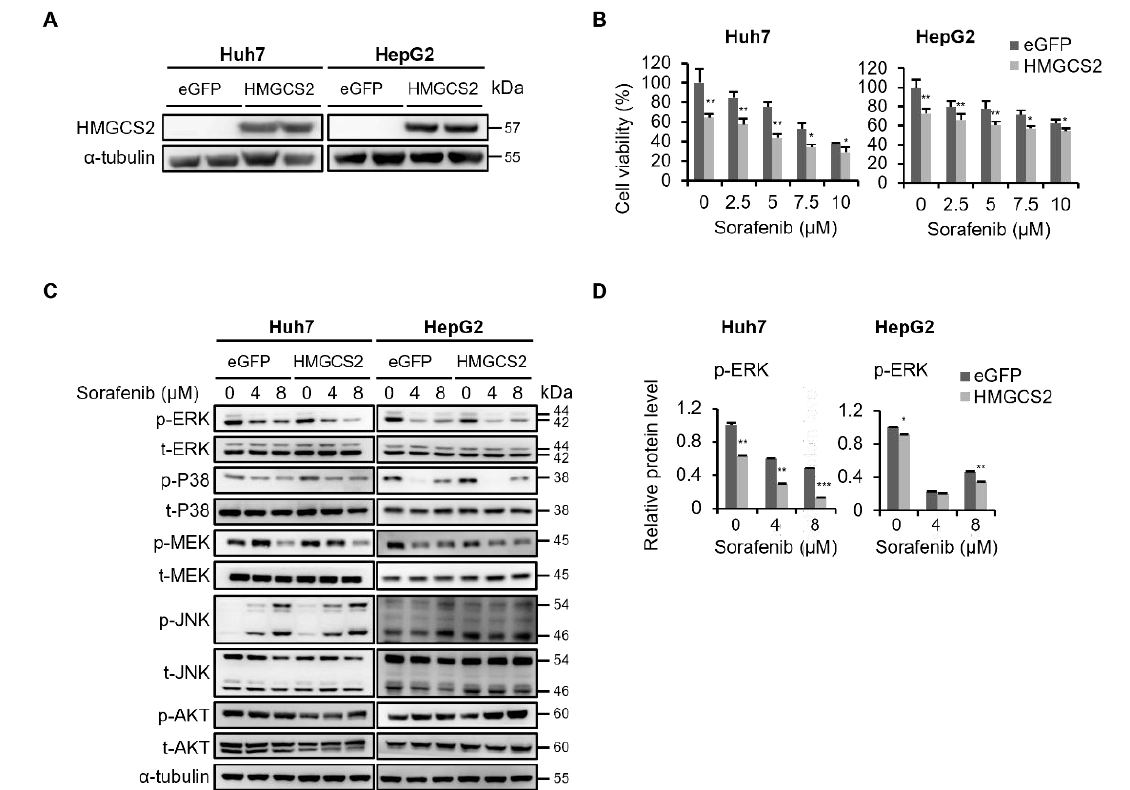
Figure 2. Overexpression of HMGCS2 in sorafenib-treated Huh7 and HepG2 cells exhibited an inhibitory effect on mitogen-activated protein kinase (MAPK)/extracellular signal-regulated kinase (ERK) activation. ( A ) Western blot analysis of HMGCS2 overexpression in Huh7 and HepG2 cells. ( B ) Enhanced green fluorescent protein (eGFP) control and HMGCS2-overexpressing Huh7 and HepG2 cells were treated with 0, 2.5, 5, 7.5, and 10 μM sorafenib for 48 h, and an MTT assay was conducted to detect the cell viability. ( C ) eGFP control and HMGCS2-overexpressing cells were treated with sorafenib (0, 4, and 8 μM) for 48 h. phosphorylated (p)- and total (t)- MAPK- and AKT- related signaling cascades were evaluated by Western blotting. α-Tubulin was used as an internal control. The representative data are obtained from three independent experiments. ( D ) Western blot images from Figure 2C, quantified by using the ImageJ software. * p < 0.05; ** p < 0.01; *** p < 0.001 vs. the eGFP control. Data are shown as the mean ± SD.